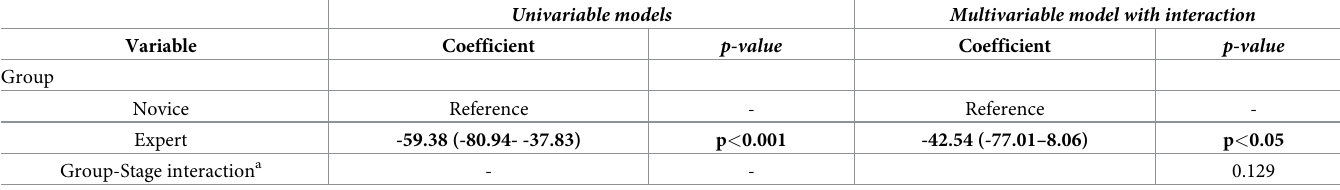
Table 1. Univariable and multivariable linear analysis to determine differences in time by group and its interaction with stage.